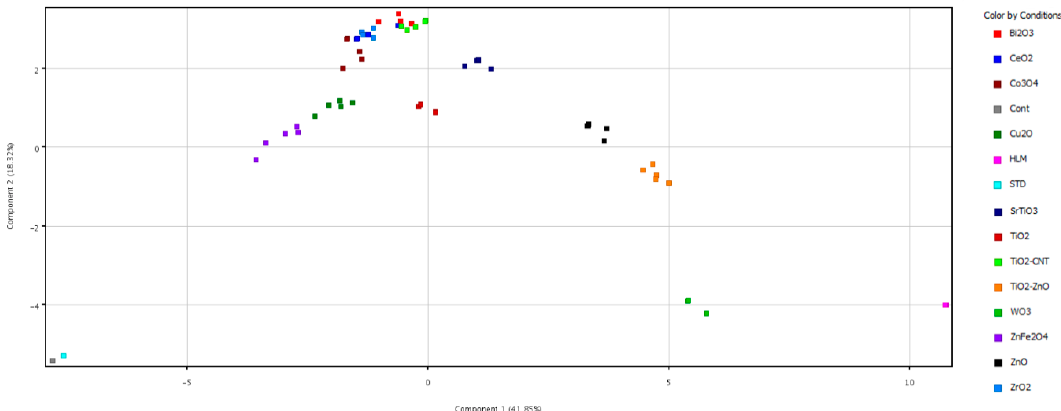
Figure 1. 2D PCA plot of the standard sample (STD), Control (Cont), HLM after 120 min of incubation and photocatalytic experiments samples after 60 min of irradiation.